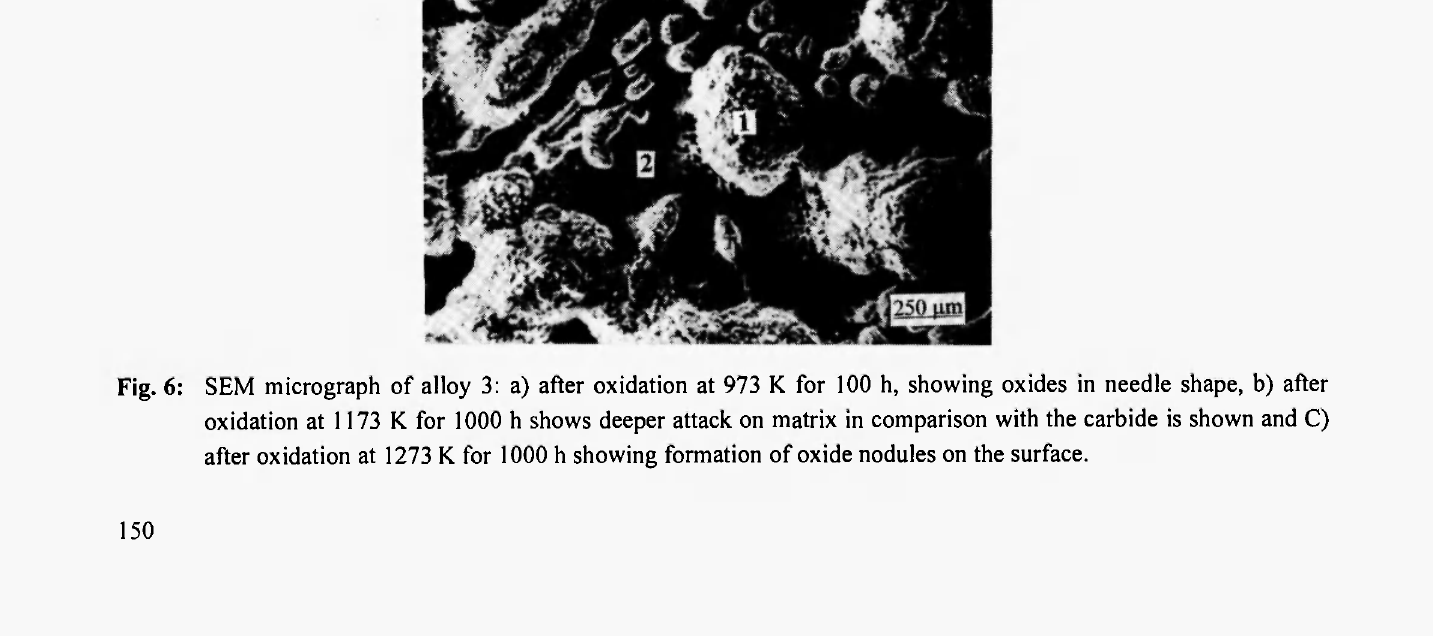
Fig. 5: SEM micrograph of alloy 2 after oxidation at 1273 Κ for 1000 h shows development of platelet like particles in the oxide scale.